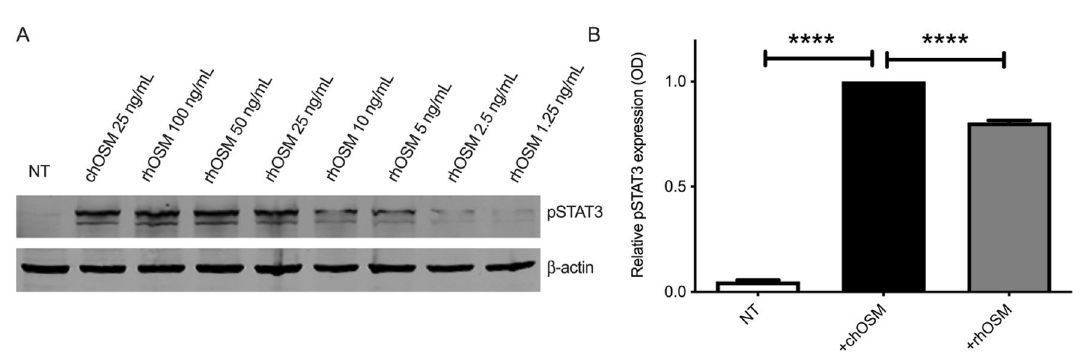
Figure 3. Recombinant OSM can effectively activate the STAT3 pathway in human breast cancer cell line, T47D. ( A ) T47D cells were untreated (NT), treated with commercial OSM (chOSM) or treated with increasing concentrations of recombinant OSM (rhOSM) for 30 min and levels of phosphorylated STAT3 (PSTAT3;Y705) were evaluated via immunoblot assay (representative blot from n = 2). pSTAT3 induction within cells treated with rhOSM show a similar trend to commercial OSM. Uncropped image shown in Supplemental Fig. S11. ( B ) Relative pSTAT3 expression in T47D breast cancer cells with no treatment (NT; white bar), or treatment with 25 ng/mL chOSM (black bar), or 25 ng/mL rhOSM (grey bar) over 30 min show significant increase in pSTAT3 levels detected via ELISA assay compared to NT and significance was observed between both treatment groups. Data expressed as mean ± SD from three replicates by one-way ANOVA with Tukey’s post-test (**** p value <